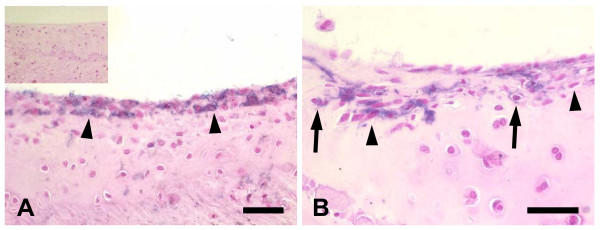
Utility of irradiated, bone marrow-transplanted, marker tolerant rats for regenerative studies and cell tracking. When hPLAP-tg BMC were injected into the knee joint of irradiated WT (hPLAP-BMT) rats, there is a 2 – 3 cells wide layer of donor cells (arrowheads) on the cartilage surface, 1 week post-injection (A). Inset in (A) shows lack of hPLAP-staining in the articular cartilage of an irradiated WT (hPLAP-BMT) control rat not injected with transgenic BMC. Four weeks post-injection, transgenic donor cells have adopted a fibroblast-like (arrowheads) or chondrocyte-like (arrows) appearance, and show incorporation into the surrounding chondrocyte matrix of host origin (B). Five-μm-thick undecalcified MMA sections of ethanol-fixed knee joints stained for hPLAP activity after heat pretreatment and counterstained with nuclear fast red. Bar = 50 μm.